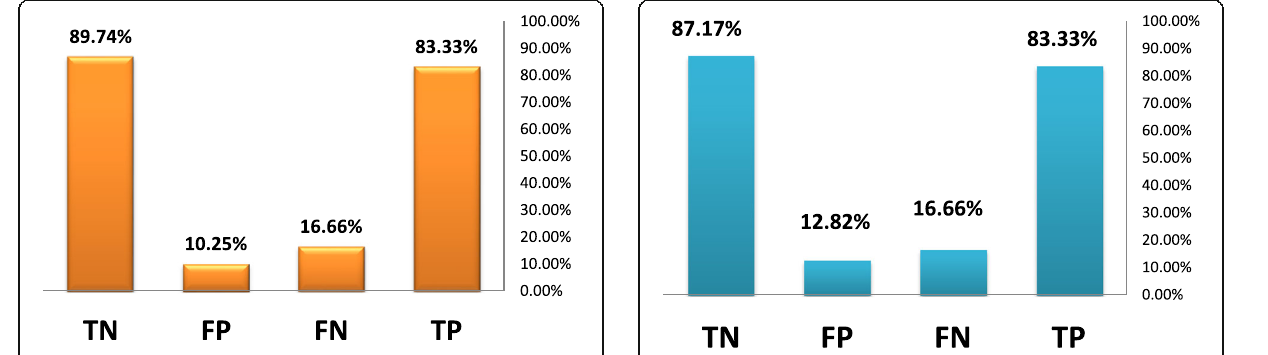
Fig. 4 Association between tomosynthesis findings and final diagnoses in the studied group